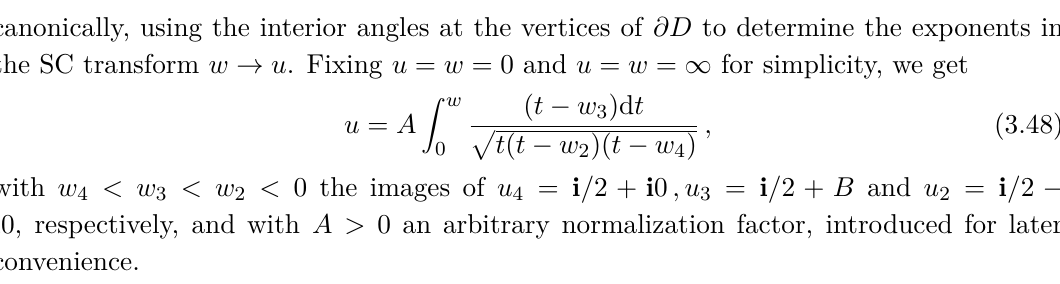
Figure 7 . The conformal mapping u → w = 1 /r ( u ) 2 maps the domain D to the upper half- plane H , and vice versa. In particular, the boundaries map into each other owing to the reflection symmetry and periodicity of r ( u ) . The table indicates the values of the map at the marked points on the